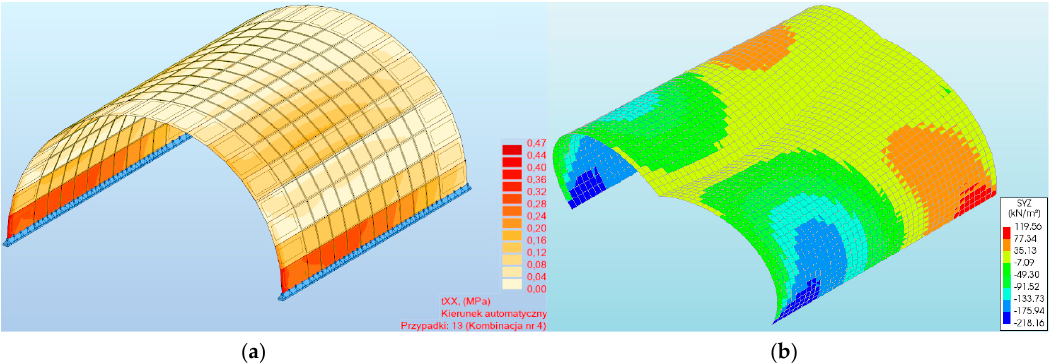
Figure 13. Maximum shear stresses of a three-hinged arch viaduct for the program: ( a ) #1, ( b ) #2.